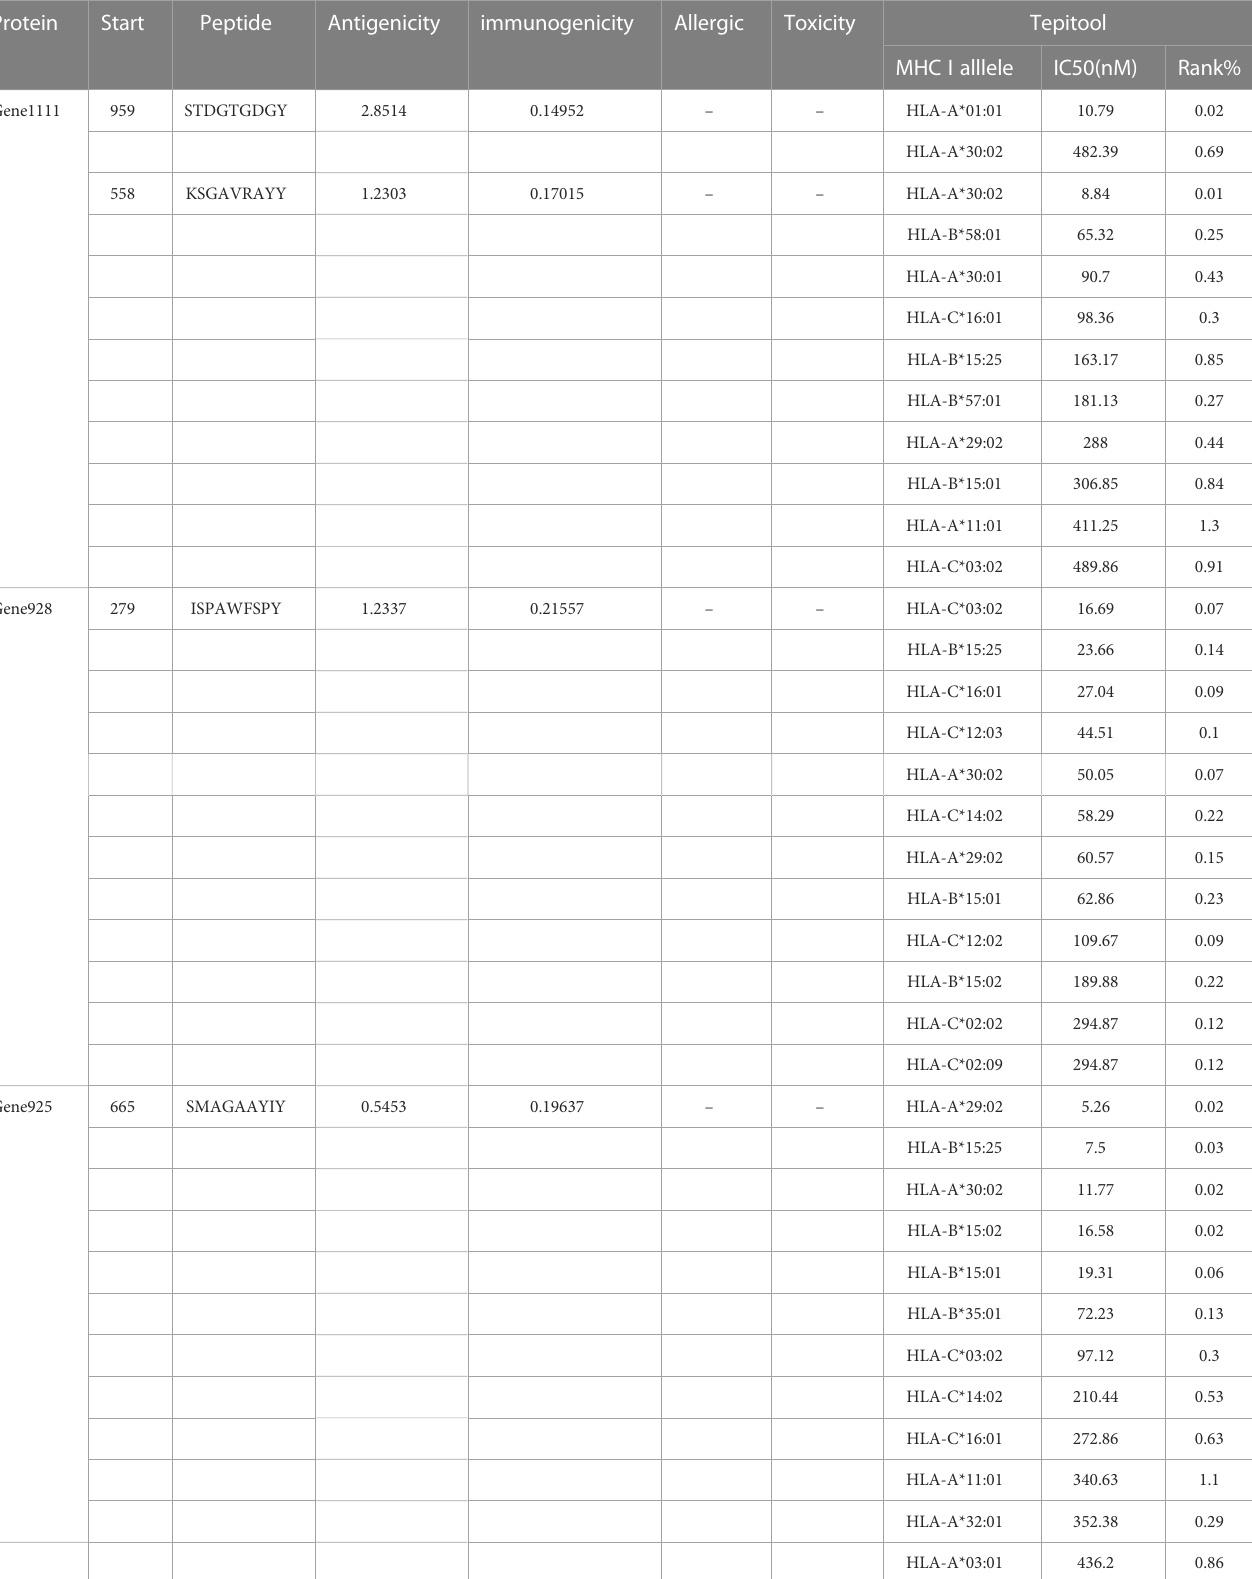
TABLE 2 The selected CTL epitopes for the vaccine construct.